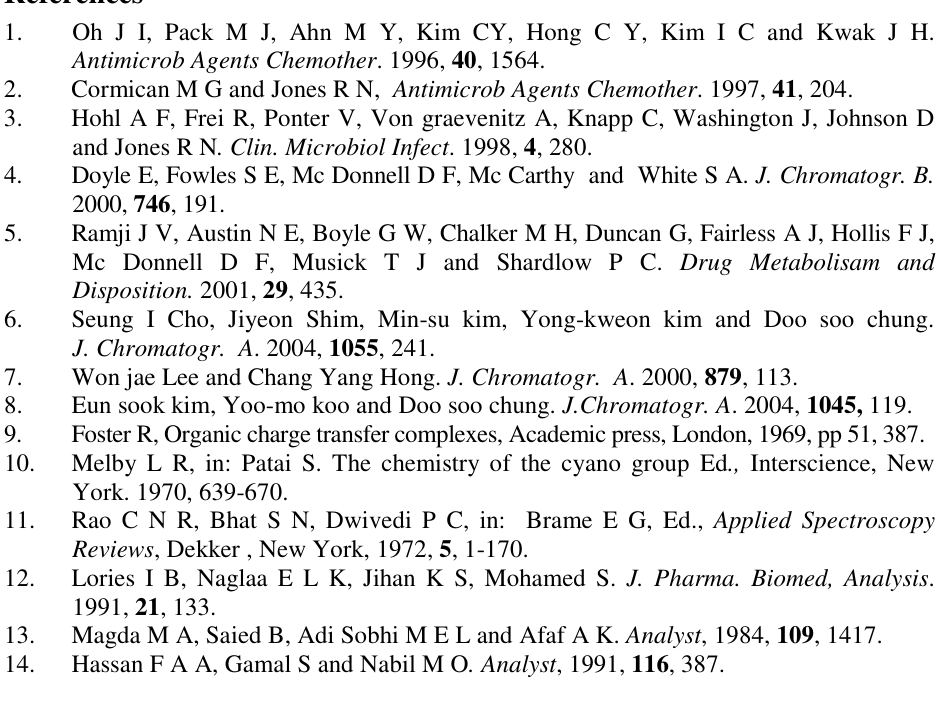
* Average of five independent